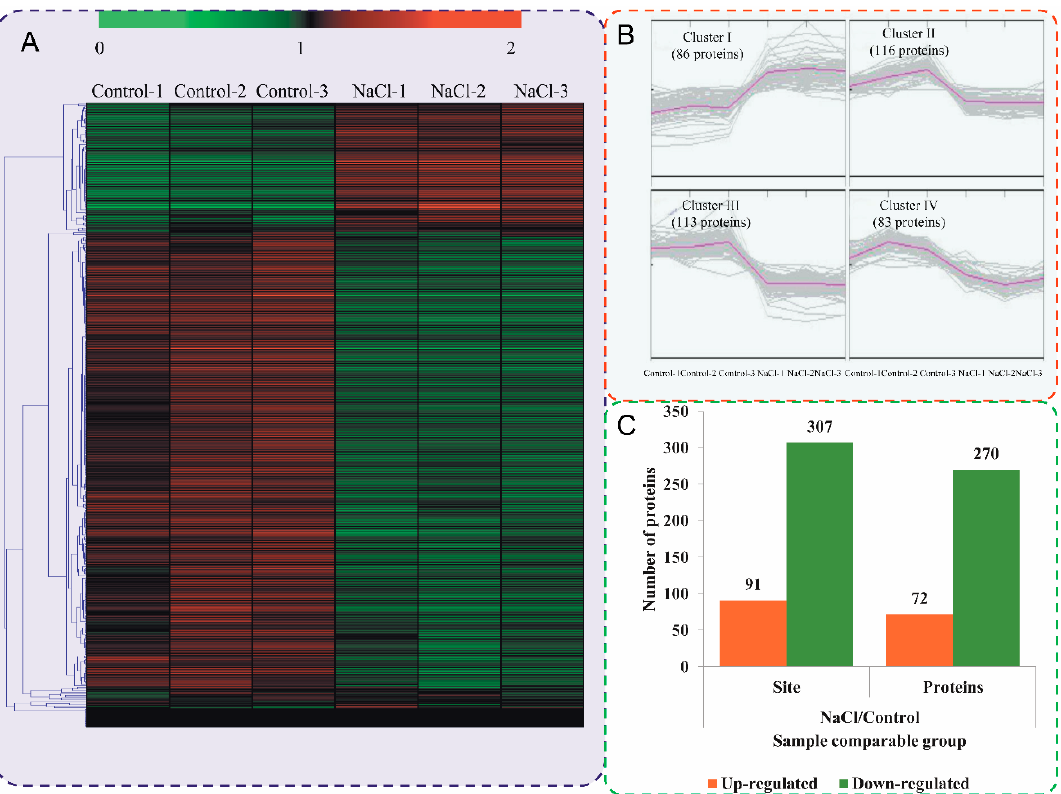
Figure 3. Impacts of salt stress treatment on phosphorylation proteome levels in okra. ( A ) Expression profiles of the DPPs in response to salt stress. ( B ) All DPPs were analyzed and clustered into four major Clusters by K-means method. ( C ) The numbers of up- and downregulated phosphorylated proteins and phosphorylated sites in the salt treatment seedlings compared to the control seedlings.